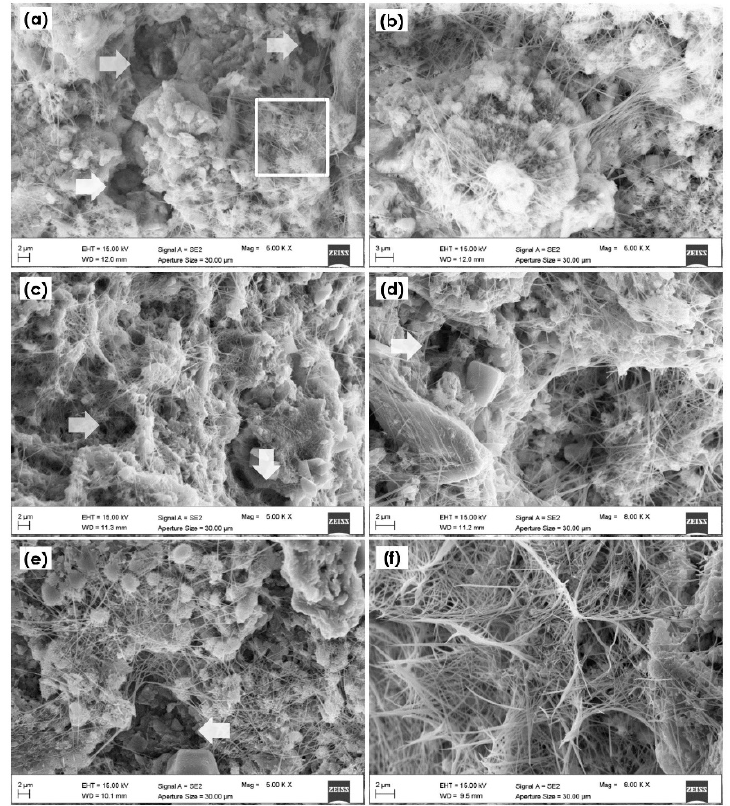
Figure 5. SEM images of soil treated with 7% CaO, compacted at optimum water content after ( a , b ) 2 days of curing, ( c , d ) 7 days of curing, and ( e , f ) 28 days of curing.